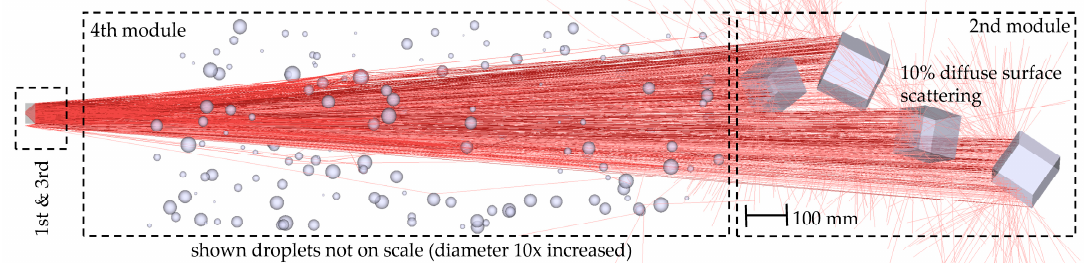
Figure 1. Simulation model for small-angle setup (max. ±8.5° acceptance angle) sectioned into its 4 modules: 1st: light source/emitter optics; 2nd: scene with 4 cube objects; 3rd: receiver optics and ToF chip; 4th: area with rain droplets.